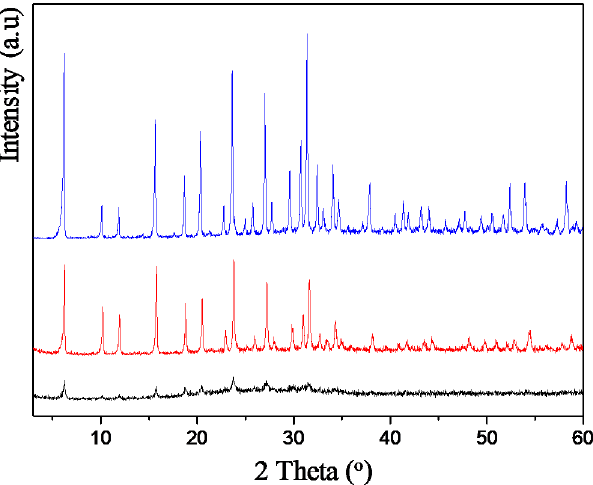
Figure 1. X-ray diffraction (XRD) patterns of Fe-NaY (blue), Fe-USY (red) and Fe-Y